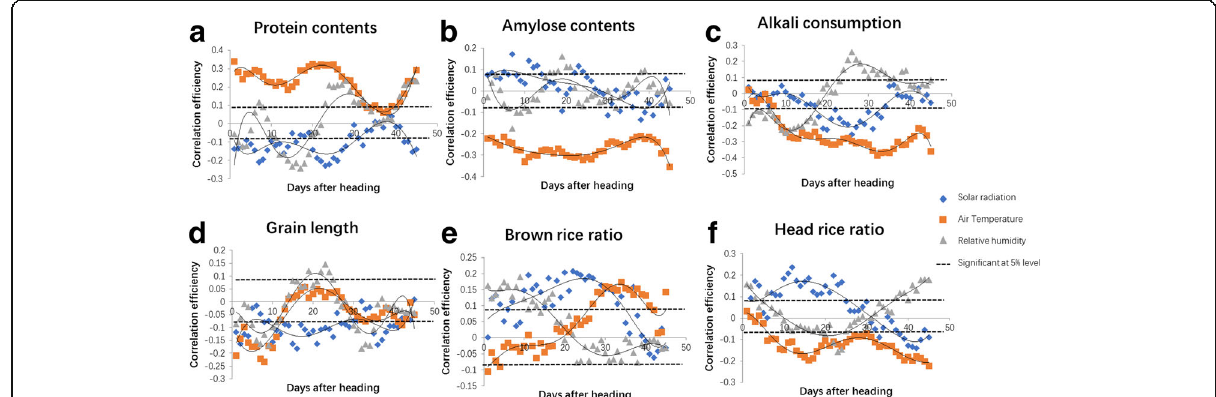
Fig. 3 The dynamic analysis of the correlation of environmental traits to quality traits. The correlation efficiency of environmental factors (solar radiation, whole day average temperature, and relative humidity) to a protein content, b amylose content, c alkali consumption, d grain length, e brown rice ratio, and f head rice ratio